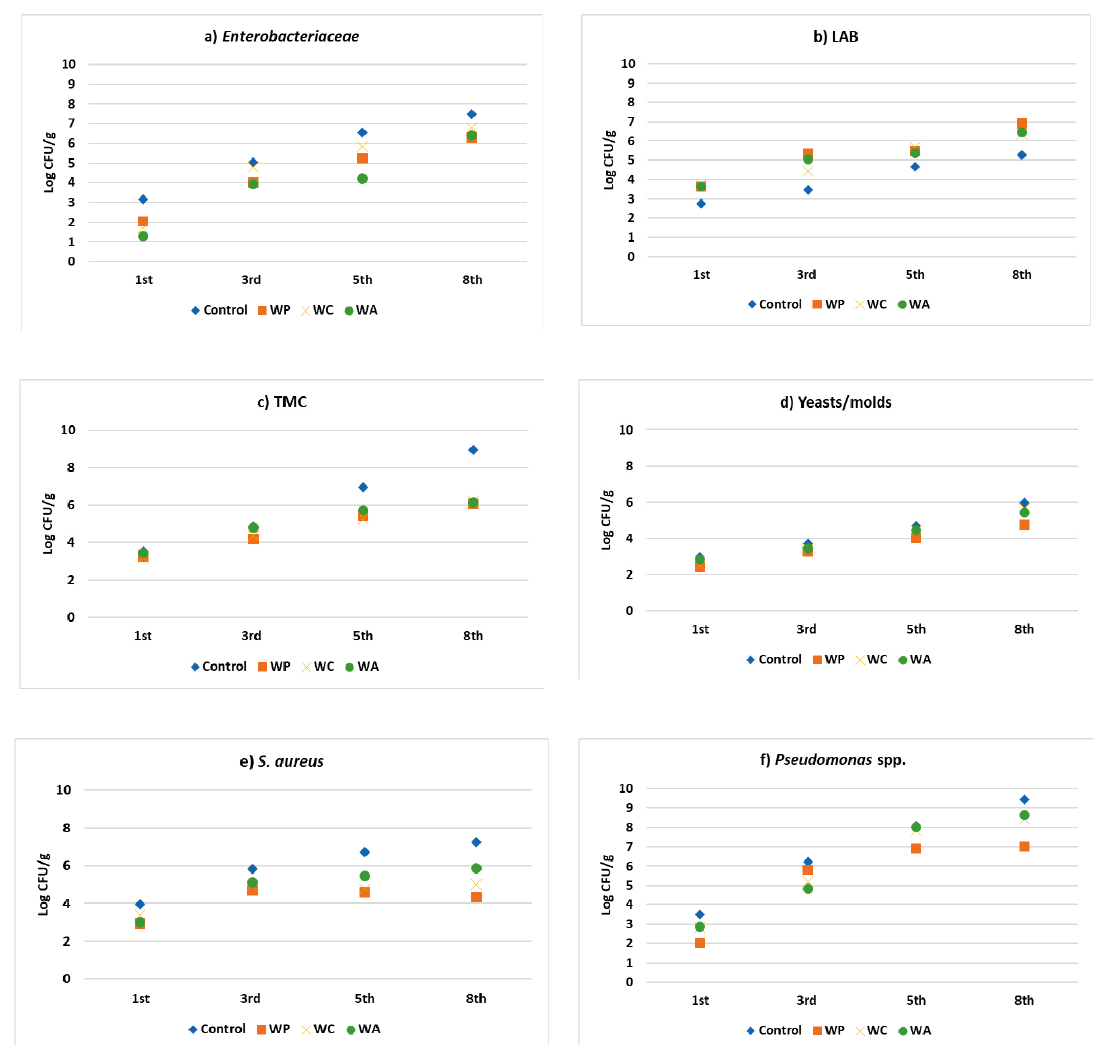
Figure 2. Viabilities (log CFU/g) of Enterobacteriaceae ( a ), lactic acid bacteria (LAB) ( b ), total mesophilic count (TMC) ( c ), yeasts/molds ( d ), S. aureus spp. ( e ), and Pseudomonas spp. ( f ) in raw meatball samples without aqueous extracts (C) and with black chokeberry (WA), pomegranate (WP), and cranberry (WC) aqueous extracts during the storage period.